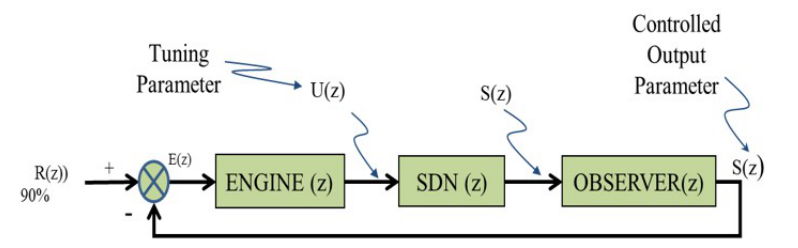
Figure 3. Modeling the SFBARMA SDN using feedback system.